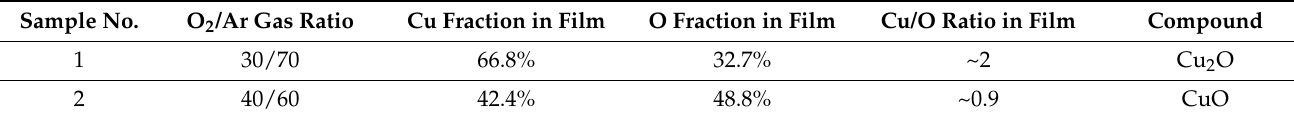
Table 1. EDS data for copper oxide intermediate